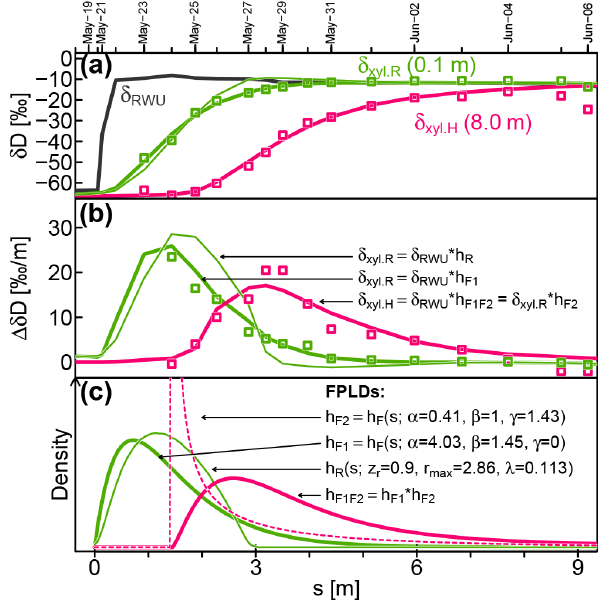
Figure 7. Measured (squares) and modeled (lines) isotopic signa- tures of RWU( δ RWU ) and xylem water at the stem base ( δ xyl.R ) and at 8m above the ground ( δ xyl.H ). (c) The FPLDs used to transform the modeled δ RWU to δ xyl as depicted in (a) and (b) . The “*” oper- ator stands for convolution.